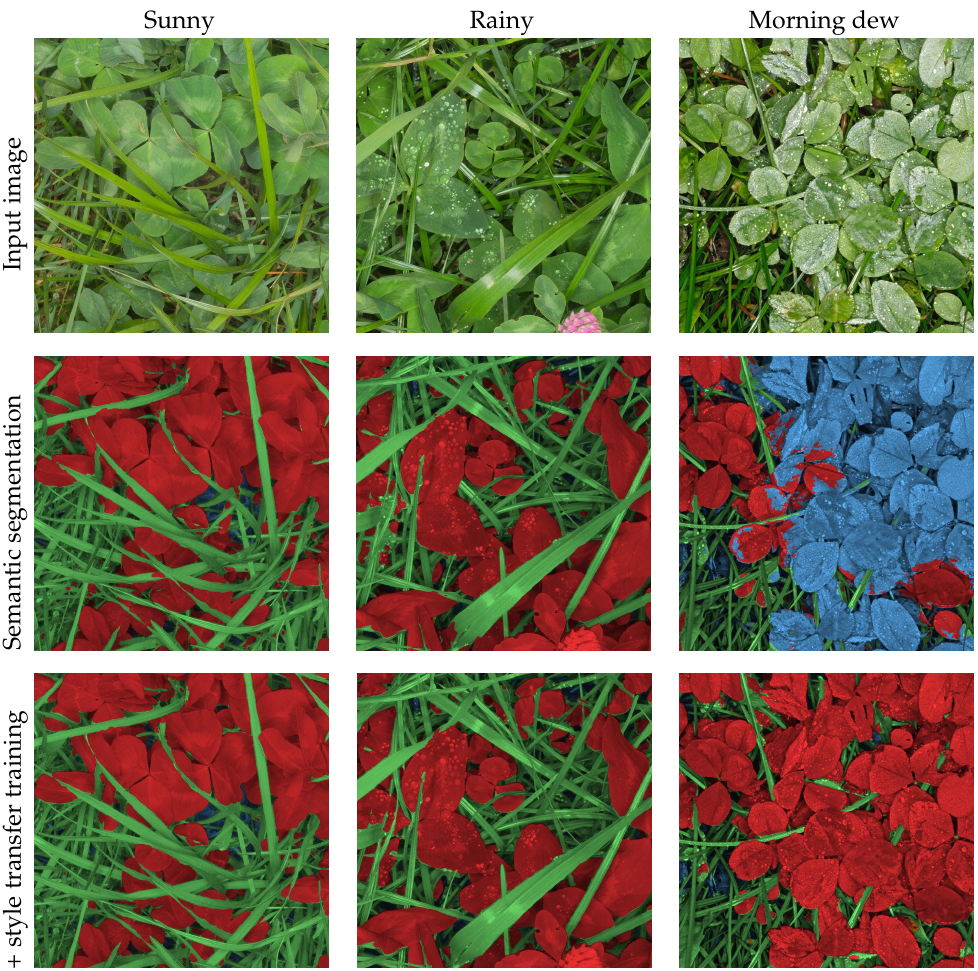
900 pixel image crops of the weather conditions effect on image Figure 6. First row: Illustrative 900 × quality depending on droplet size. ( left ) Sunny condition without droplets. ( center ) Although the large droplets from rain are visible, the captured leaf texture is comparable to sunny conditions. ( right ) In dewy conditions, especially the clover leaf texture appearance is highly affected by the specular reflections from the camera flash. Second row: The semantic segmentation results with a model trained with traditional image augmentation. Third row: The semantic segmentation results when including style transferred dewy conditions into the synthetic training data. Green is grass, red is clover, and blue is soil and